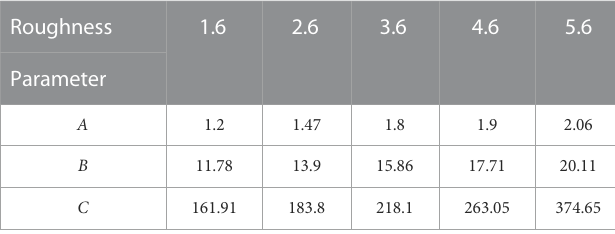
TABLE 6 Values of parameters a 、 b 、 c . Roughness